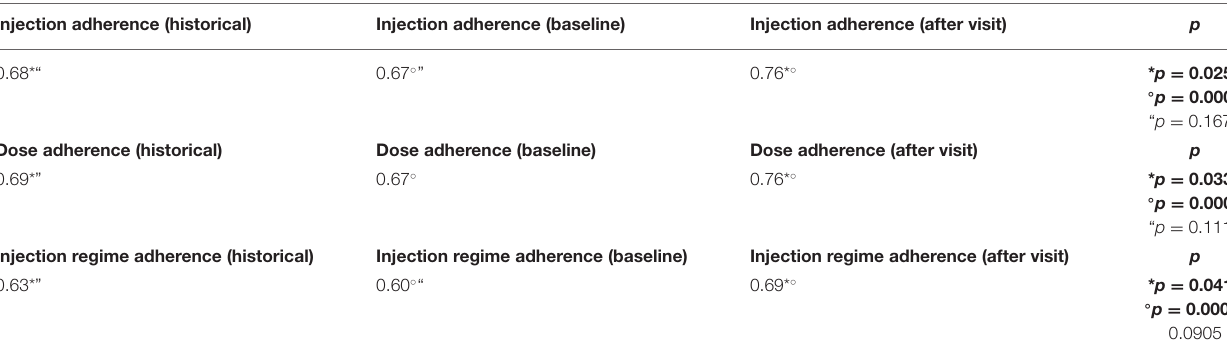
TABLE 4 | Comparison between the paired groups: Median results of the Wilcoxon signed-rank test.